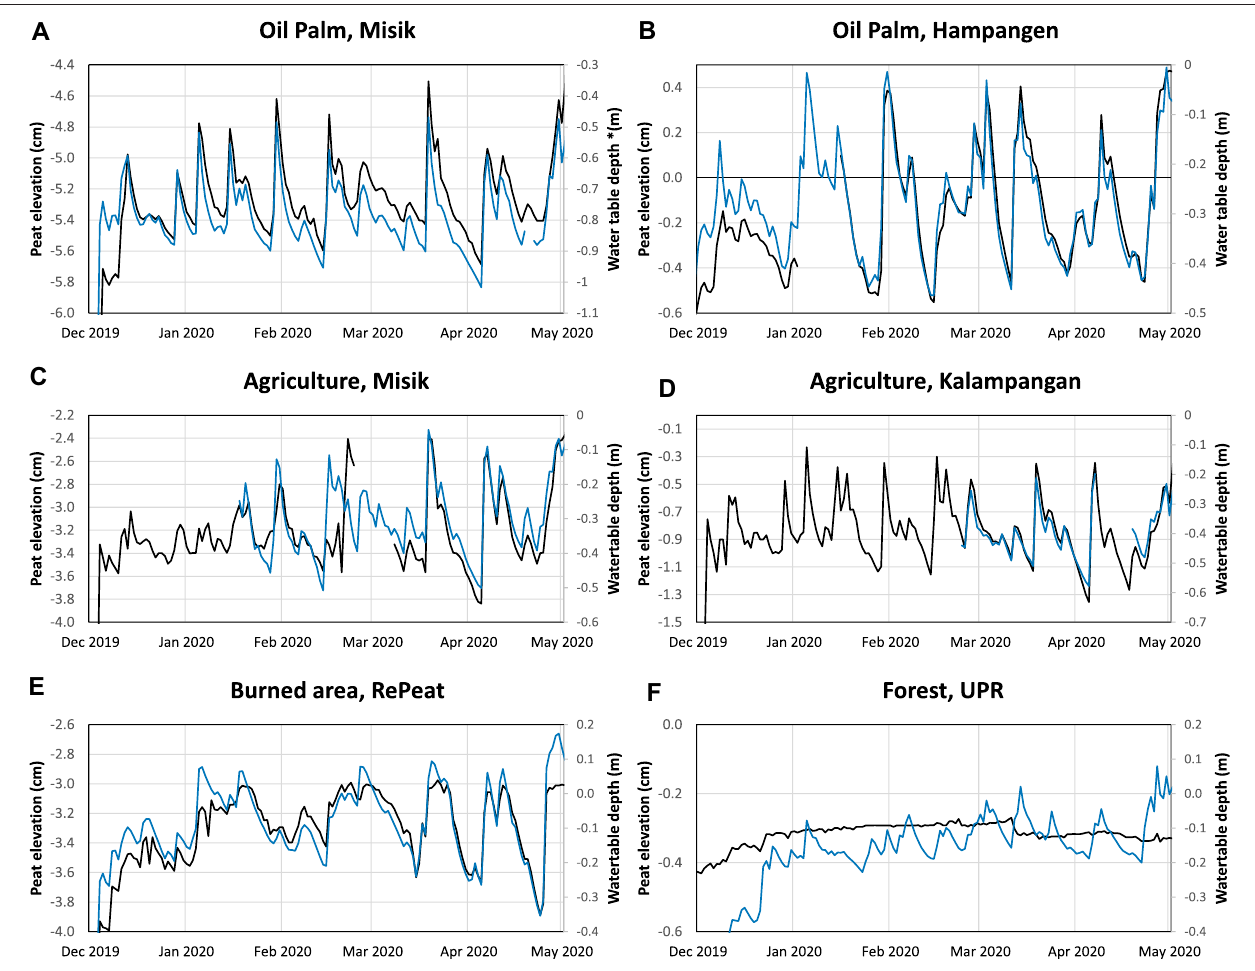
FIGURE 10 | Timeseriesofpeatelevation (black, left y -axis)and water tabledepth (blue,right y -axis)for six sites withelevation and water table datafor the early 2020 wet season. Y -axis ranges are adjusted according to the magnitude of observed short-term variation at each site, y -axis increments are the same for all sites (thus denser horizontal gridlines indicate sites with greater short-term peat motion). (A – F) are there as site identi fi ers to enable speci fi c panels to be referenced from the text.